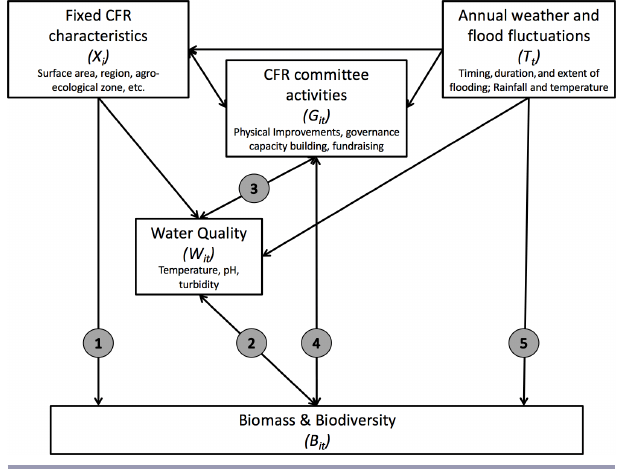
Fig. 1 . Conceptual diagram outlining the determinants